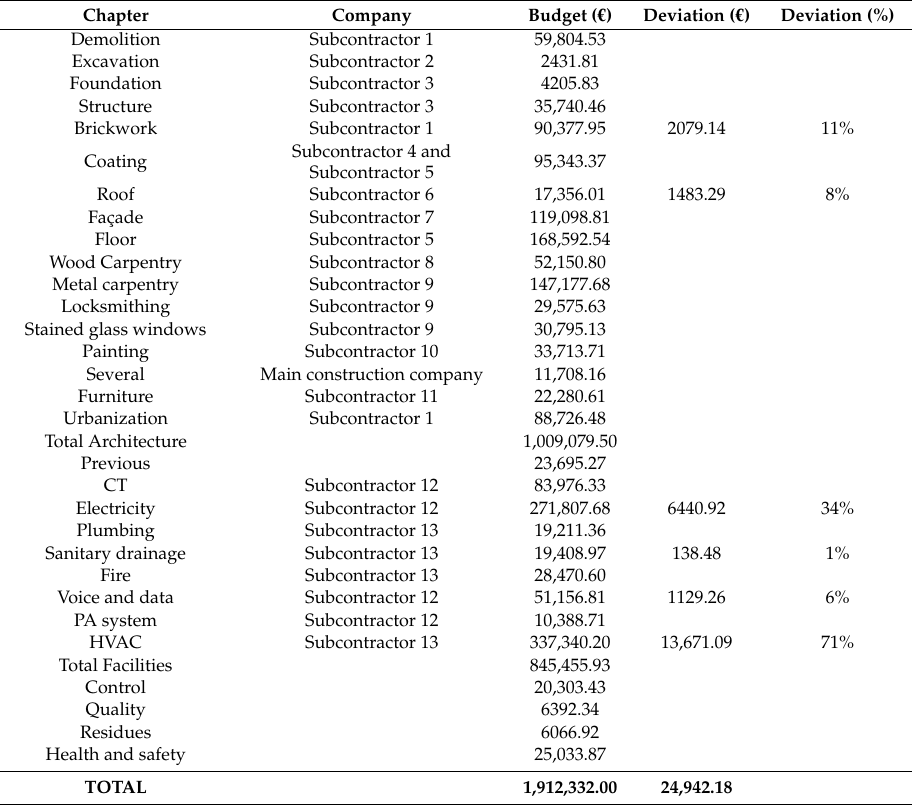
Table 3. Data derived from the case